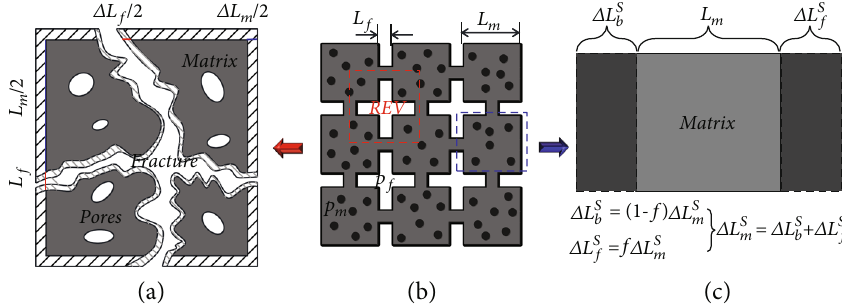
Figure 5: Schematic diagram of gas adsorption-induced internal swelling deformation. (a) Representative elementary volume (REV). (b) Coal structure model. (c) Internal swelling deformation caused by gas adsorption.